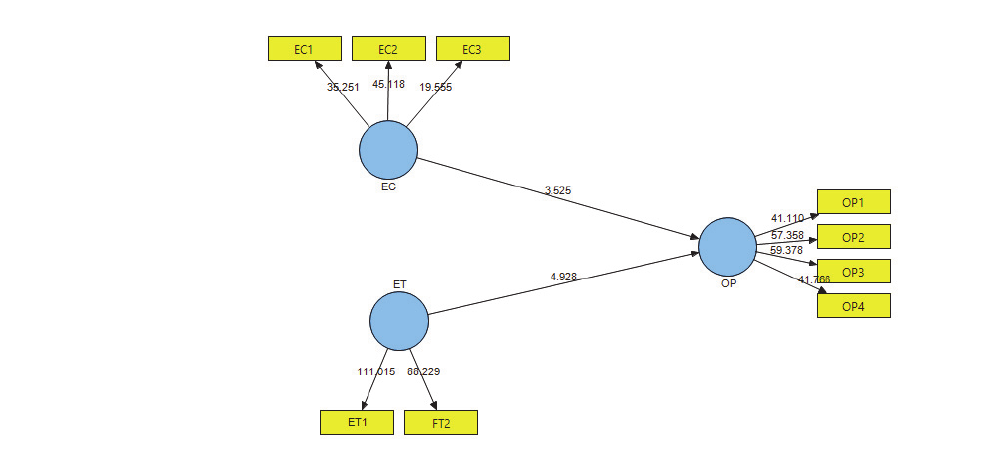
Fig. 2. Structural Modeling Result- Direct